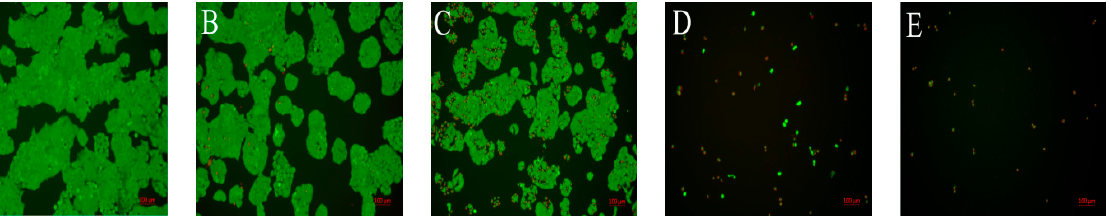
Figure 13. Live/dead staining (100×) when C 12 DDGPB and HeLa cells were cocultured for 48 h. ( A ) Control, ( B ) 5 μ g/mL, ( C ) 10 μ g/mL, ( D ) 25 μ g/mL, ( E ) 50 μ g/mL. (Note: HeLa cells normally grow in the form of agglomeration).